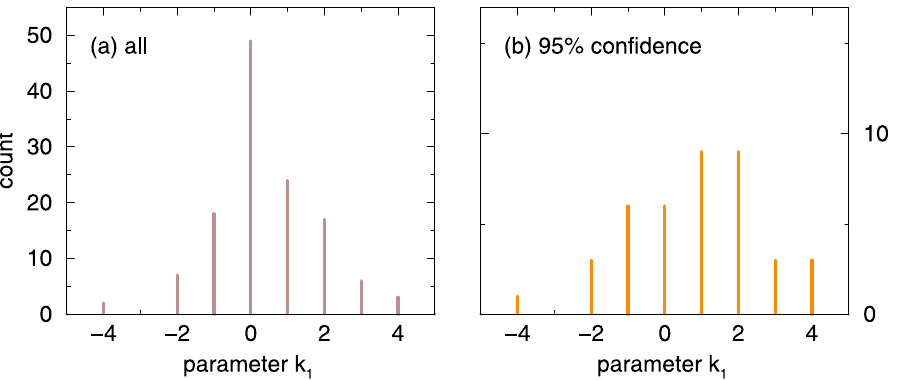
Fig 2. Histogram of the parameter k 1 from Eq (1) for (a) all considered MSAs and (b) those MSAs for which the type could be determined with at least 95% confidence. Unit bin-width was used and the bins are centered on integer values. The value k 1 = 2 means that if the total GDP increases by e.g. 5% then the share of agriculture decreases by 10%.